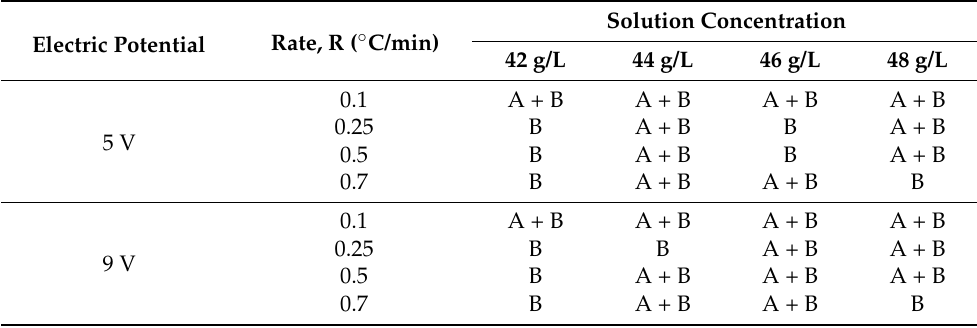
Table 3. Tabulated data for X-ray powder diffraction (XRPD). Characterisation result for the crystal product collected from polythermal crystallisation experiment.